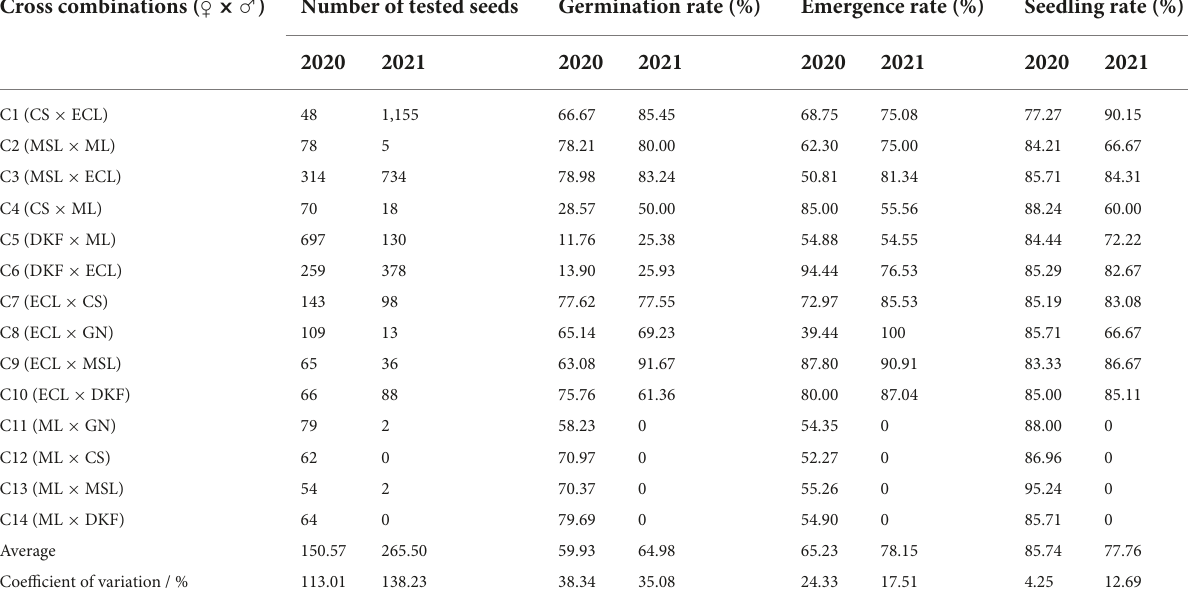
TABLE 4 Germination rate, emergence rate and seedling rate of hybrid seeds. × Cross combinations ( ) Number of tested seeds Germination rate (%) Emergence rate (%) Seedling rate ♀ ♂